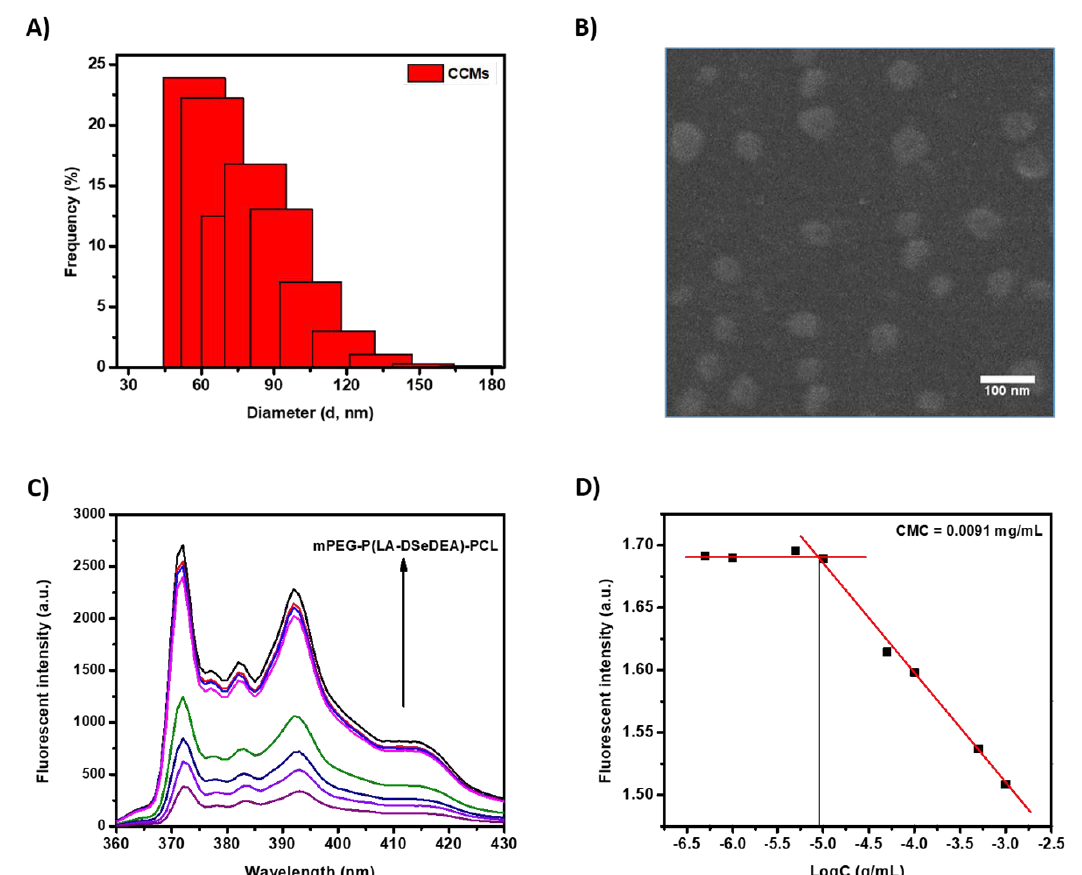
Figure 3. Particle size distribution of CCMs ( A ), SEM image of CCMs ( B ), fluorescent emission spectra of pyrene at different concentrations of mPEG-P(LA-DSeDEA)-PCL ( C ) and its CMC value ( D ). The scale bar in the SEM image is 100 nm.